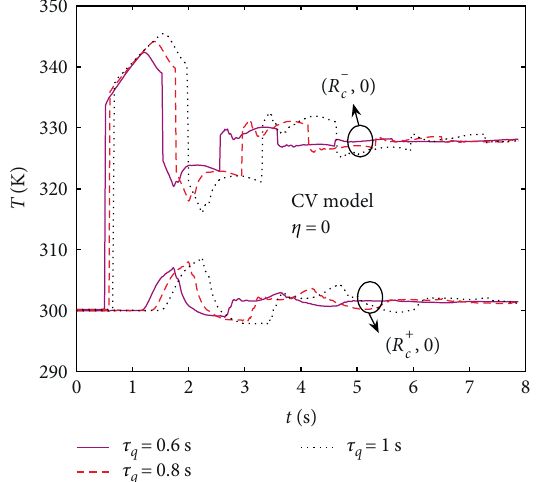
Figure 7: Effect of on the temperature history at crack face 𝜏 𝑇 midpoints for a homogeneous cylinder based on the DPL